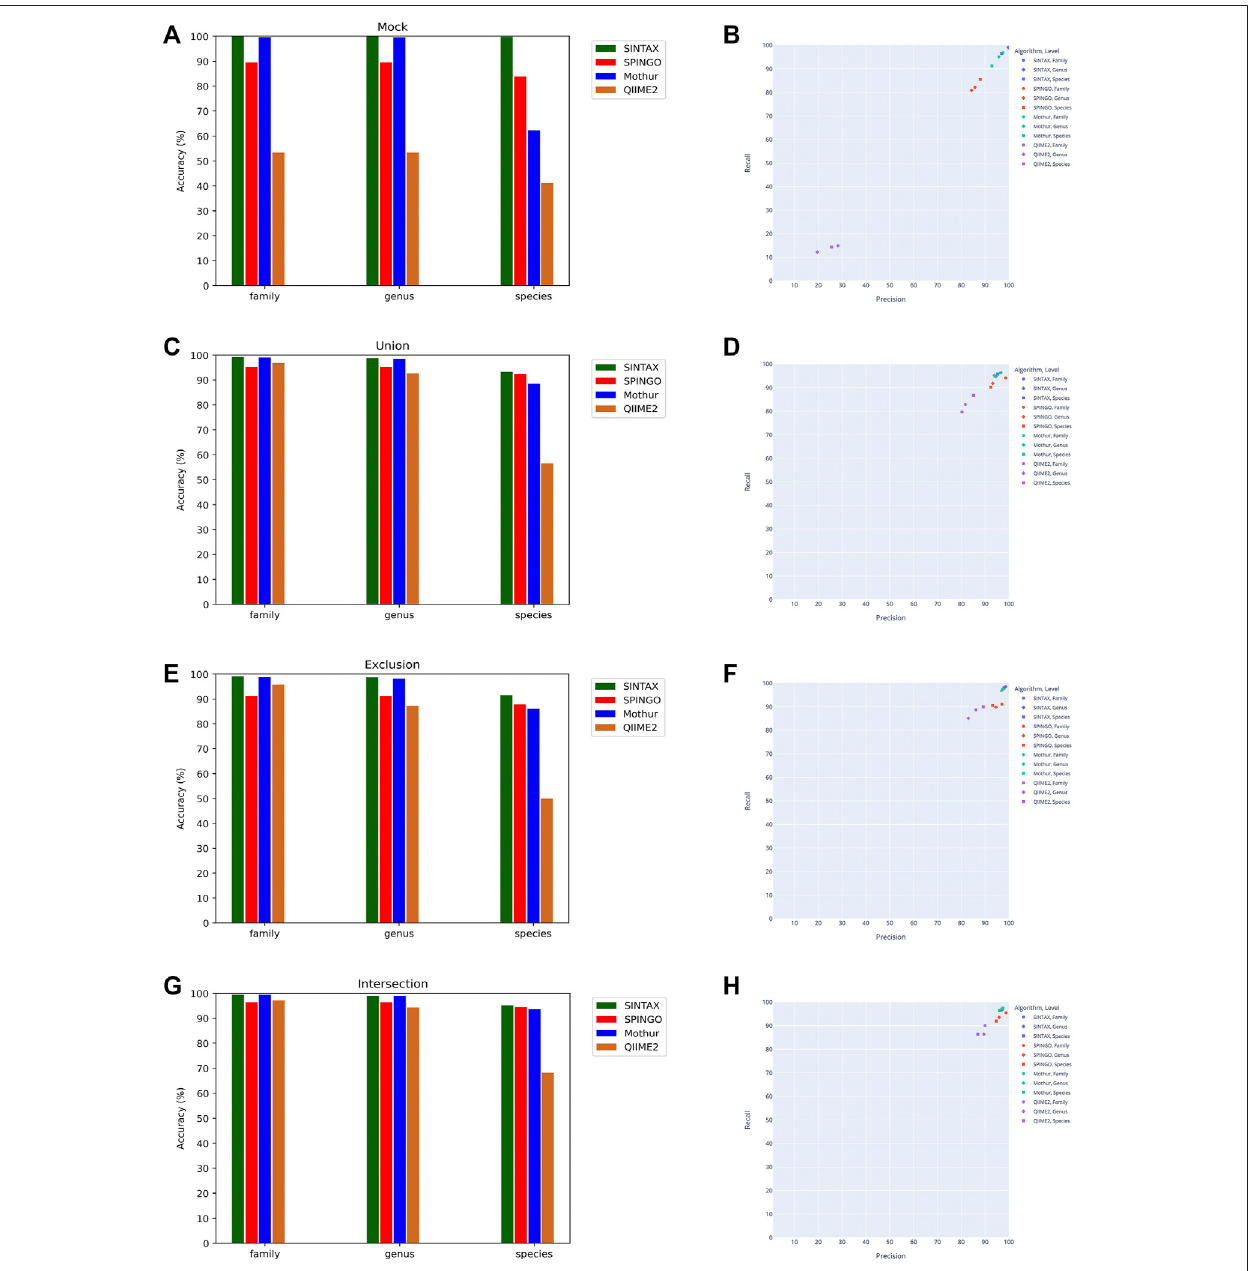
FIGURE 4 | Performance comparison of different classi fi ers using the taxonomy-based ITGDB as the reference database to classify the sequences in mock community, Union, Exclusion, and Intersection datasets. Accuracy of classifying the mock community (A) , Union dataset (C) , Exclusion dataset (E) , and Intersection dataset (G) . Precision and recall of classifying the mock community (B) , Union dataset (D) , Exclusion dataset (F) , and Intersection dataset (H)